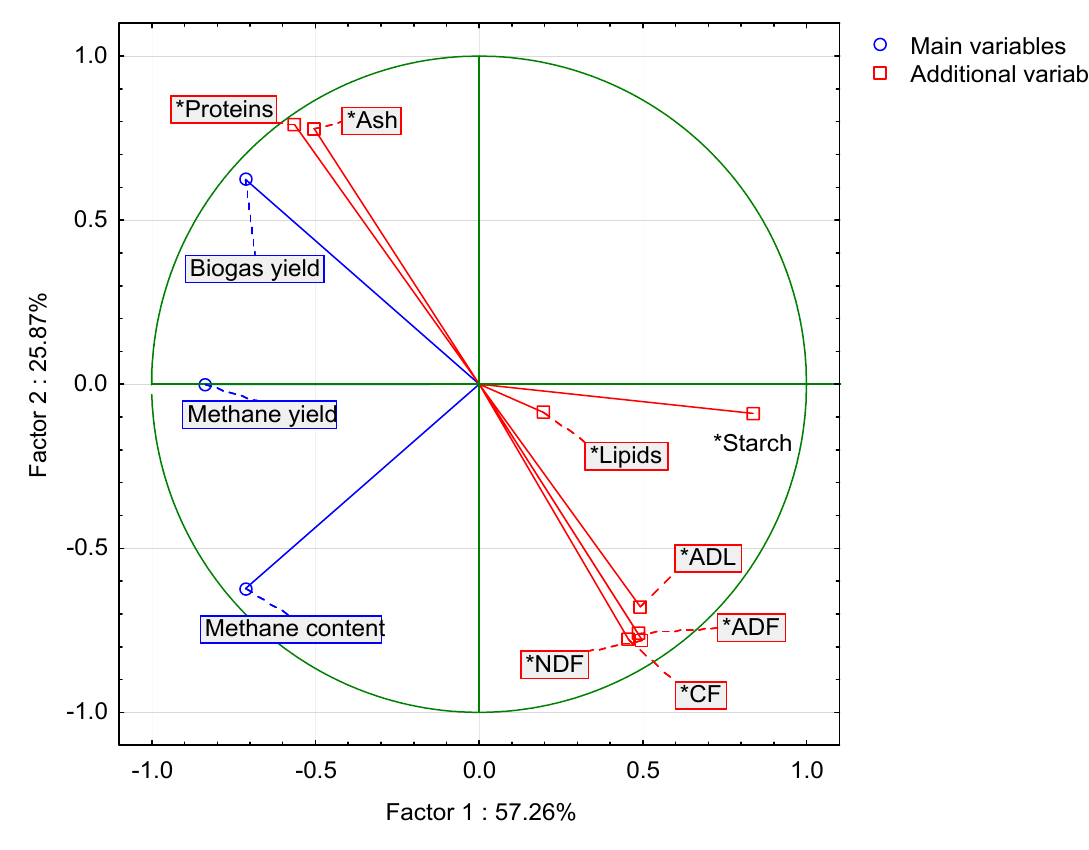
Figure 8. Projection of the variables on the factor plane (1 × 2). NDF—neutral detergent fiber; ADF—acid detergent fiber; CF—crude fiber; ADL—acid detergent lignin. Table 11. Results of PCA. Correlation of factors and variables (factor load) according to